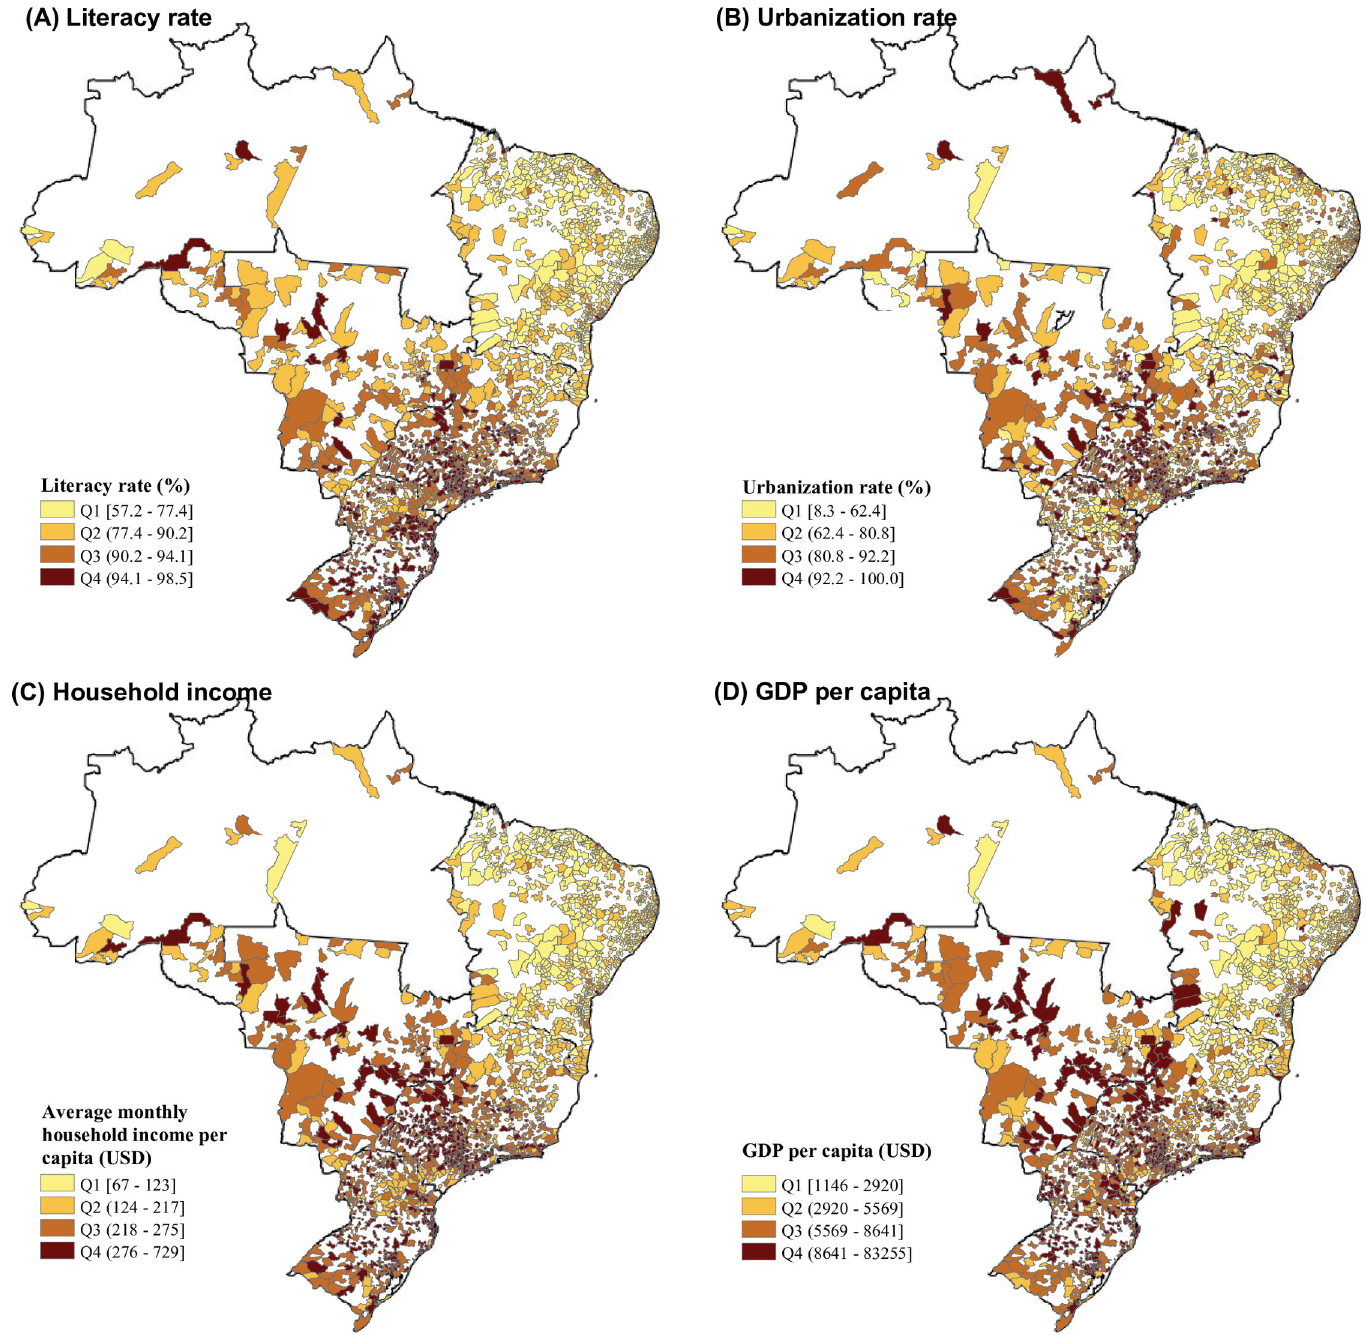
Fig 1. Mapping the average socioeconomic characteristics during 2000–2015 in 1,814 Brazilian cities. Literacy rate (A), urbanization rate (B), household income (C), and GDP per capita (D). Both GDP per capita and household income were adjusted to 2015 USD according to the Consumer Price Index. The literacy rate, urbanization rate, and GDP per capita were the 16-year average values during 2000–2015. Household income was sourced from the 2010 census of Brazil. Q1–Q4 were the 4 quartiles from the lowest to the highest. The base map of this figure was downloaded from the Brazilian Institute of Geography and Statistics (https://www.ibge.gov.br/); the base map was free and open-access. GDP, gross domestic product; USD, United States